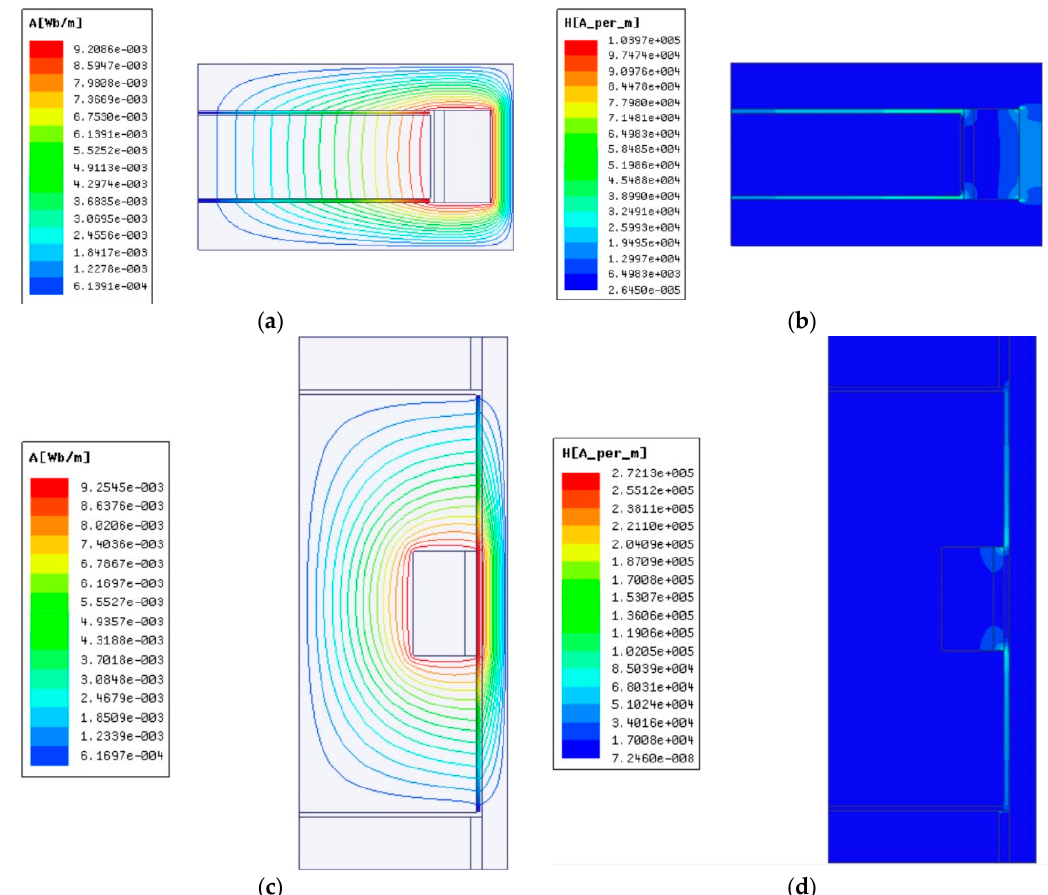
Figure 5. Results of electromagnetic field analysis: ( a ) Magnetic flux distribution of the disc ‐ type MRC; ( b ) Magnetic field intensity of the disc ‐ type MRC; ( c ) Magnetic flux distribution of the cylinder ‐ type MRC; ( d ) Magnetic field intensity of the cylinder ‐ type MRC.